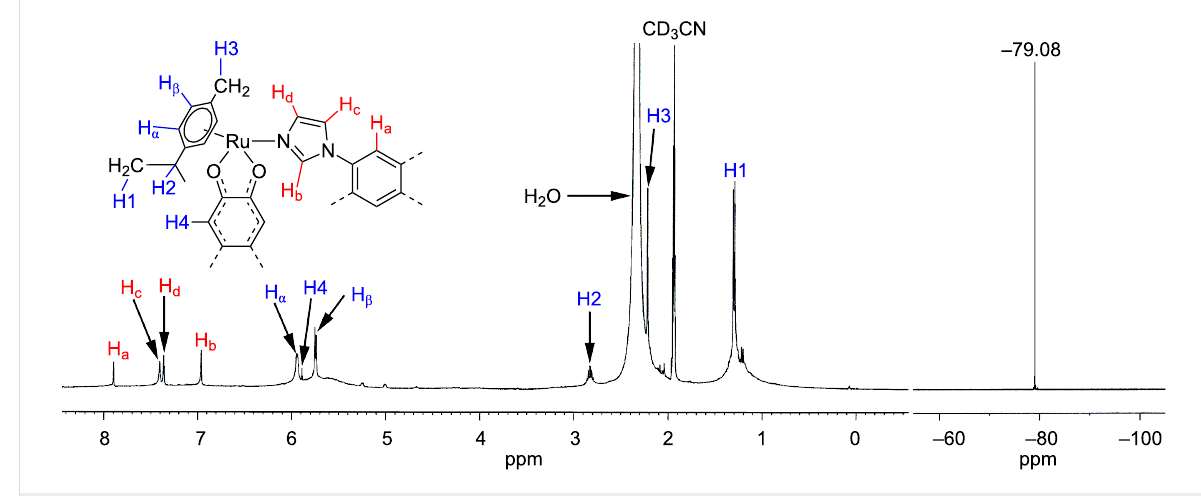
Figure 4: 1 H (left) and 19 F (right) NMR spectrum of the macrocycle 2c recorded in CD 3 CN with the peak assignments.